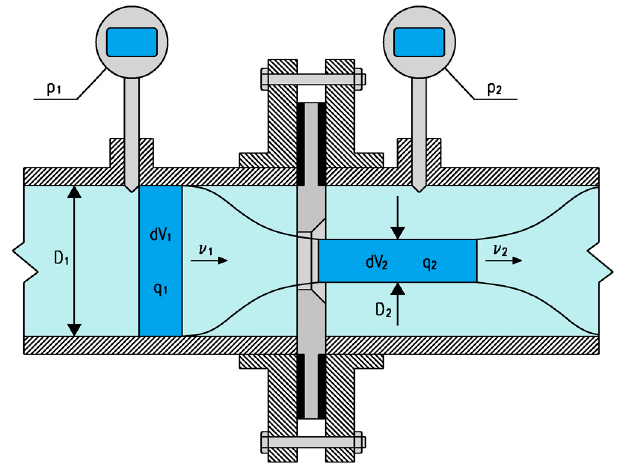
Figure 3. Section shrinkage.